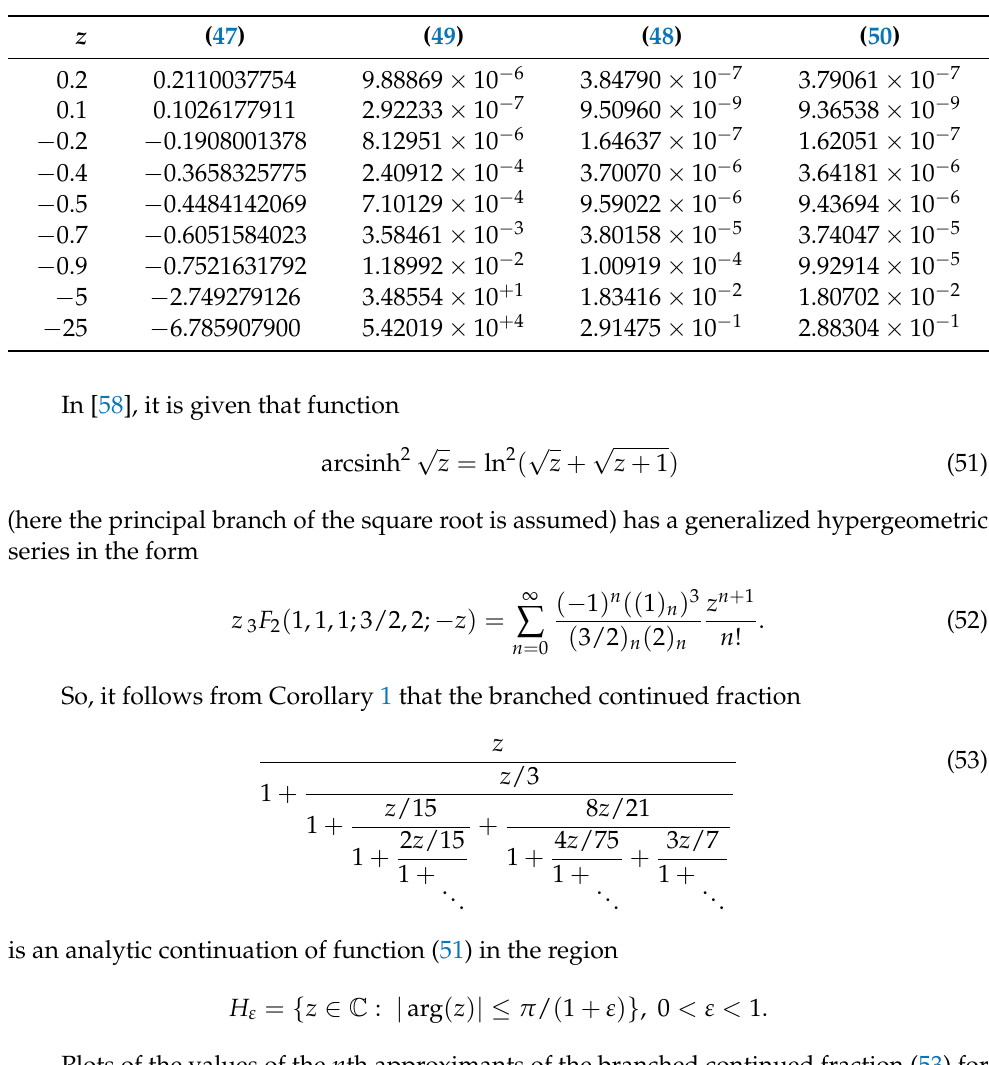
Table 2. Relative error of 5th partial sum and 5th approximants for Li 2 ( z ) .